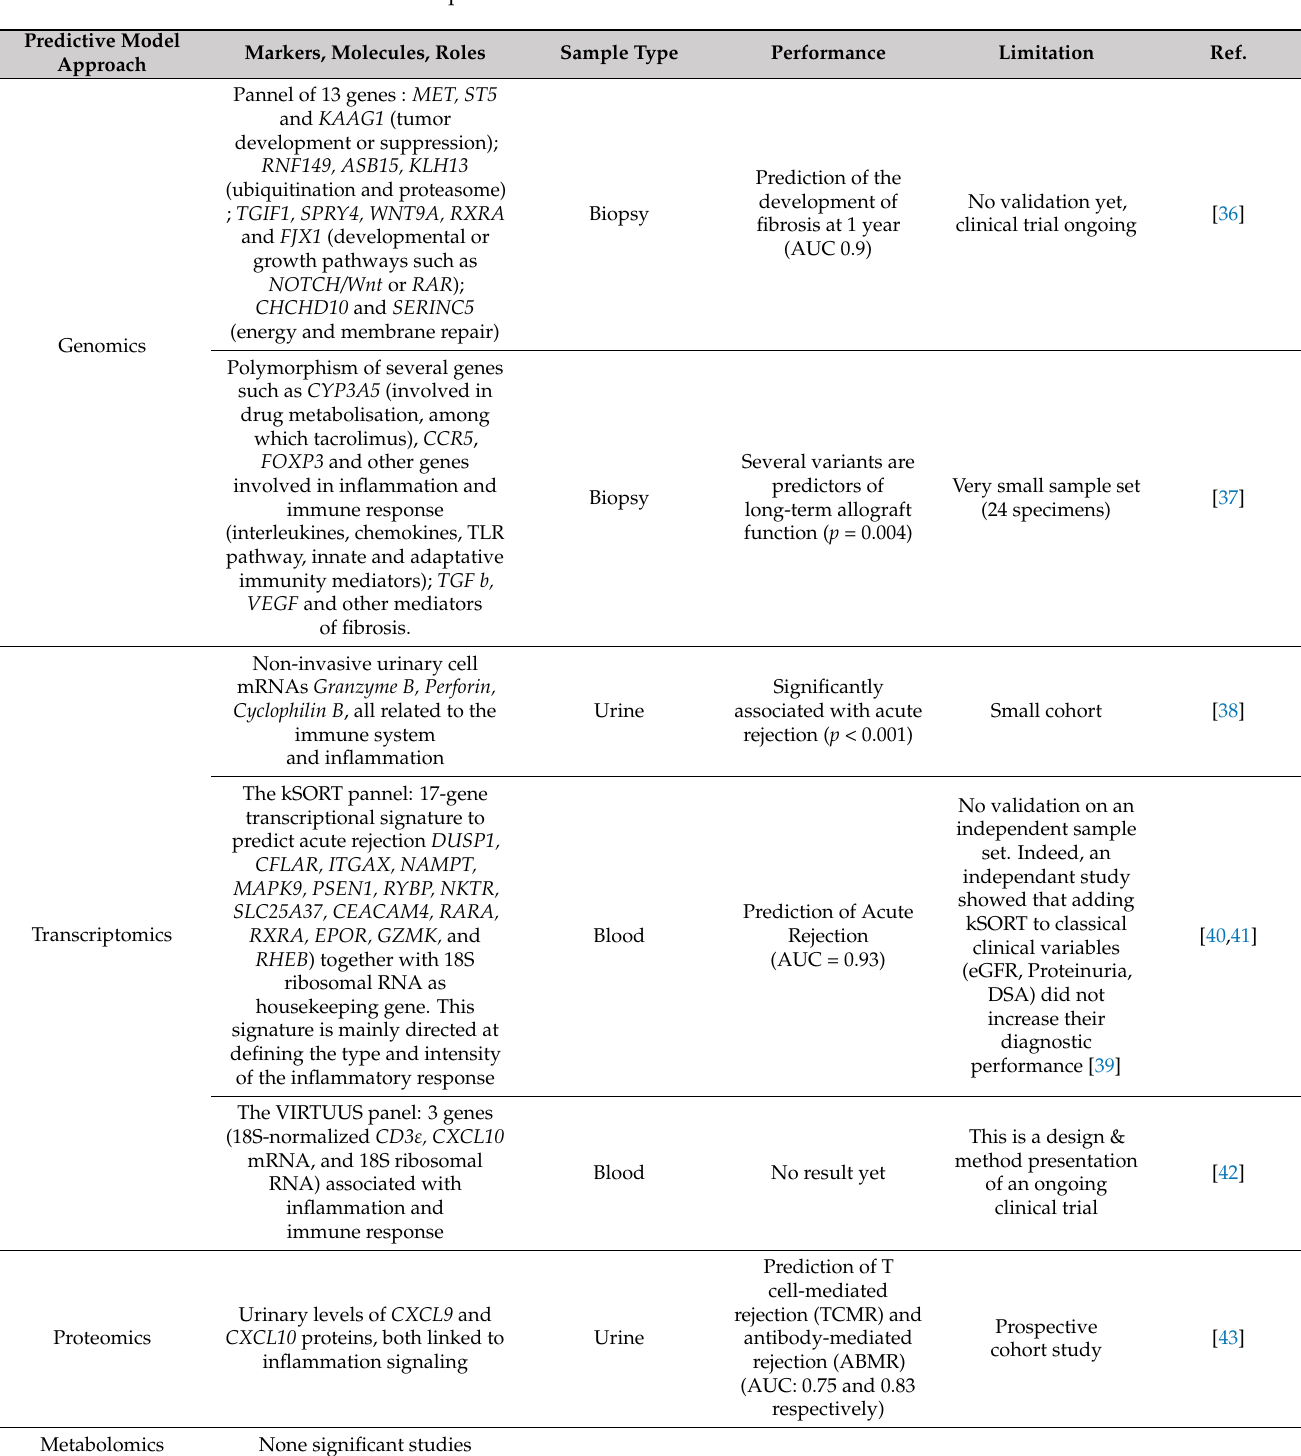
Table 2. Post-transplantation molecular biomarkers; their role and the performance as predictive tools in